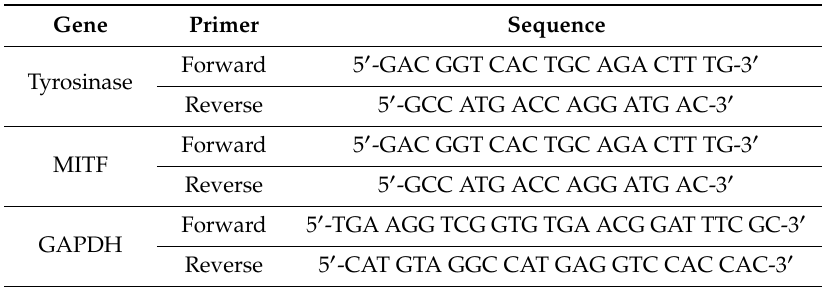
Table 2. Primer sequences for the